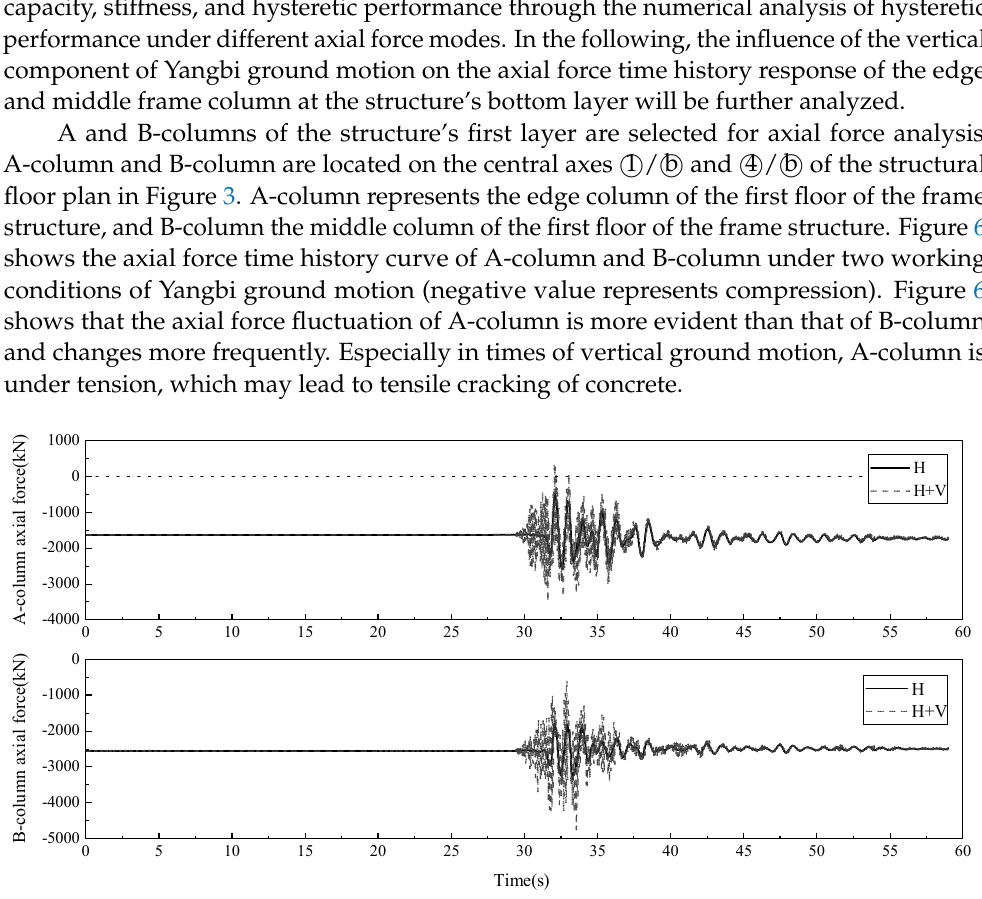
( b ) Figure 7. A − column and B − column axial force ‐ bending moment curve under two conditions of Yangbi ground motion. ( a ) A ‐ column; ( b ) B ‐ column. As can be seen in Figure 7a,b, the variation curves of axial force and bending moment of A ‐ column and B ‐ column under two working conditions are all included in the cross ‐ section N m envelope diagram. In other words, even if there is no bearing capacity dam ‐ age, the axial pressure and column bottom bending moment of the two columns under the H + V condition are greater than those under the H condition. It also shows that the influence of vertical ground motion on the loading state of frame columns can not be ig ‐ nored. In the earthquake process, both columns are in a form of large eccentric compres ‐ sion, which may reflect that the columns of the RC frame structure have good ductility and energy dissipation in the earthquake. From the variation trend of axial force with bending moment, the axial force of the two columns changes linearly with the bending